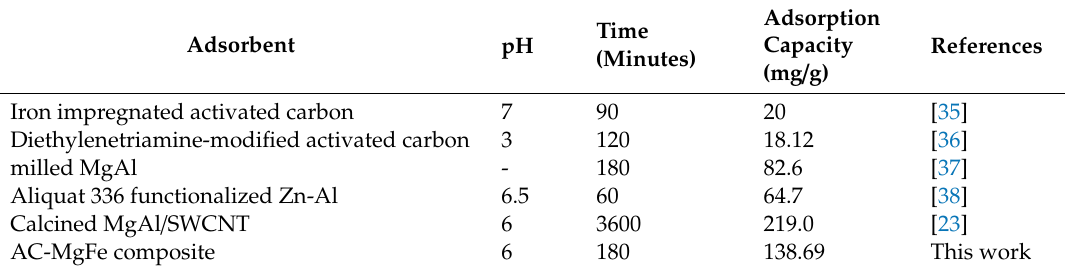
Table 4. Adsorption capacity and parameters of phenol onto recently studied